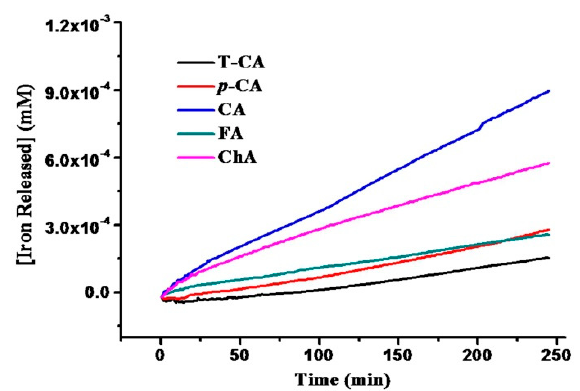
Figure 3. Kinetics of iron release from holo SSF induced by cinnamic acid derivatives. Iron release from SSF in the presence of reductants was followed by measuring the increase in absorbance at 562 nm about 250 min due to the chelation of Fe 2+ by ferrozine. Conditions: 0.15 µ M SSF, 25 µ M cinnamic acids, 50 mM Mops, pH 7.0, 0.15 M NaCl, 500 µ M ferrozine, 25 ◦